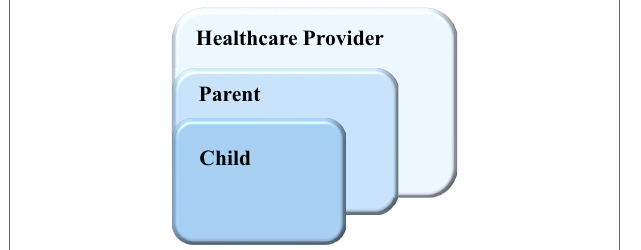
FigUre 1 | The prototype Empower Stars! video game usability assessment centered on a multilevel user approach that included children with